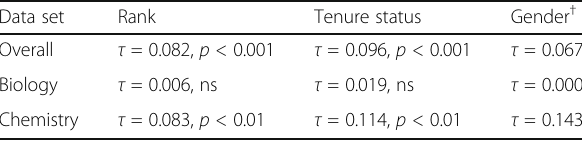
Table 4 Summary of homophily overall and by field Data